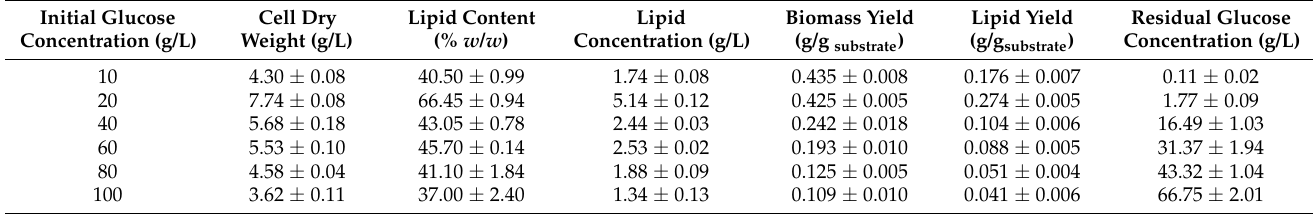
Table 1. Growth of Pseudanabaena sp. at various initial glucose concentrations. Initial Glucose Concentration